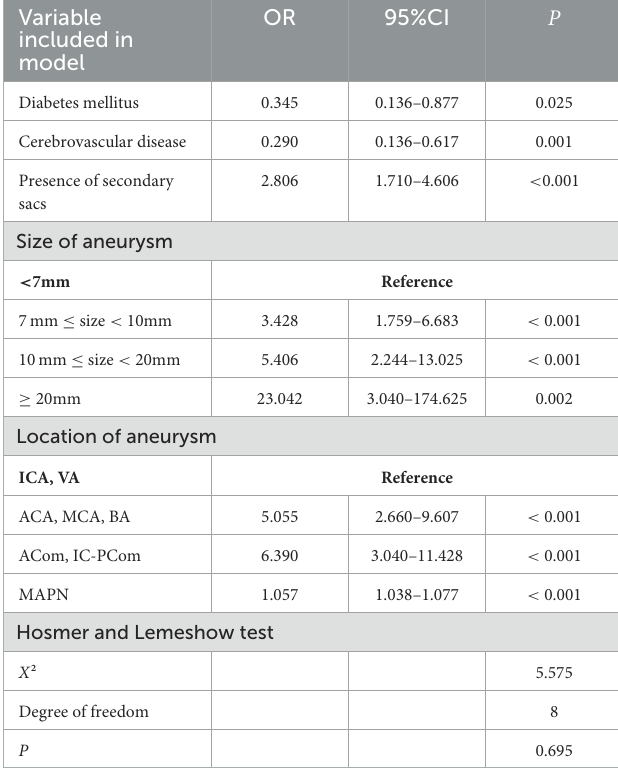
TABLE 2 Logistic regression table for risk factors associated with rupture of cerebral aneurysms. Variable included